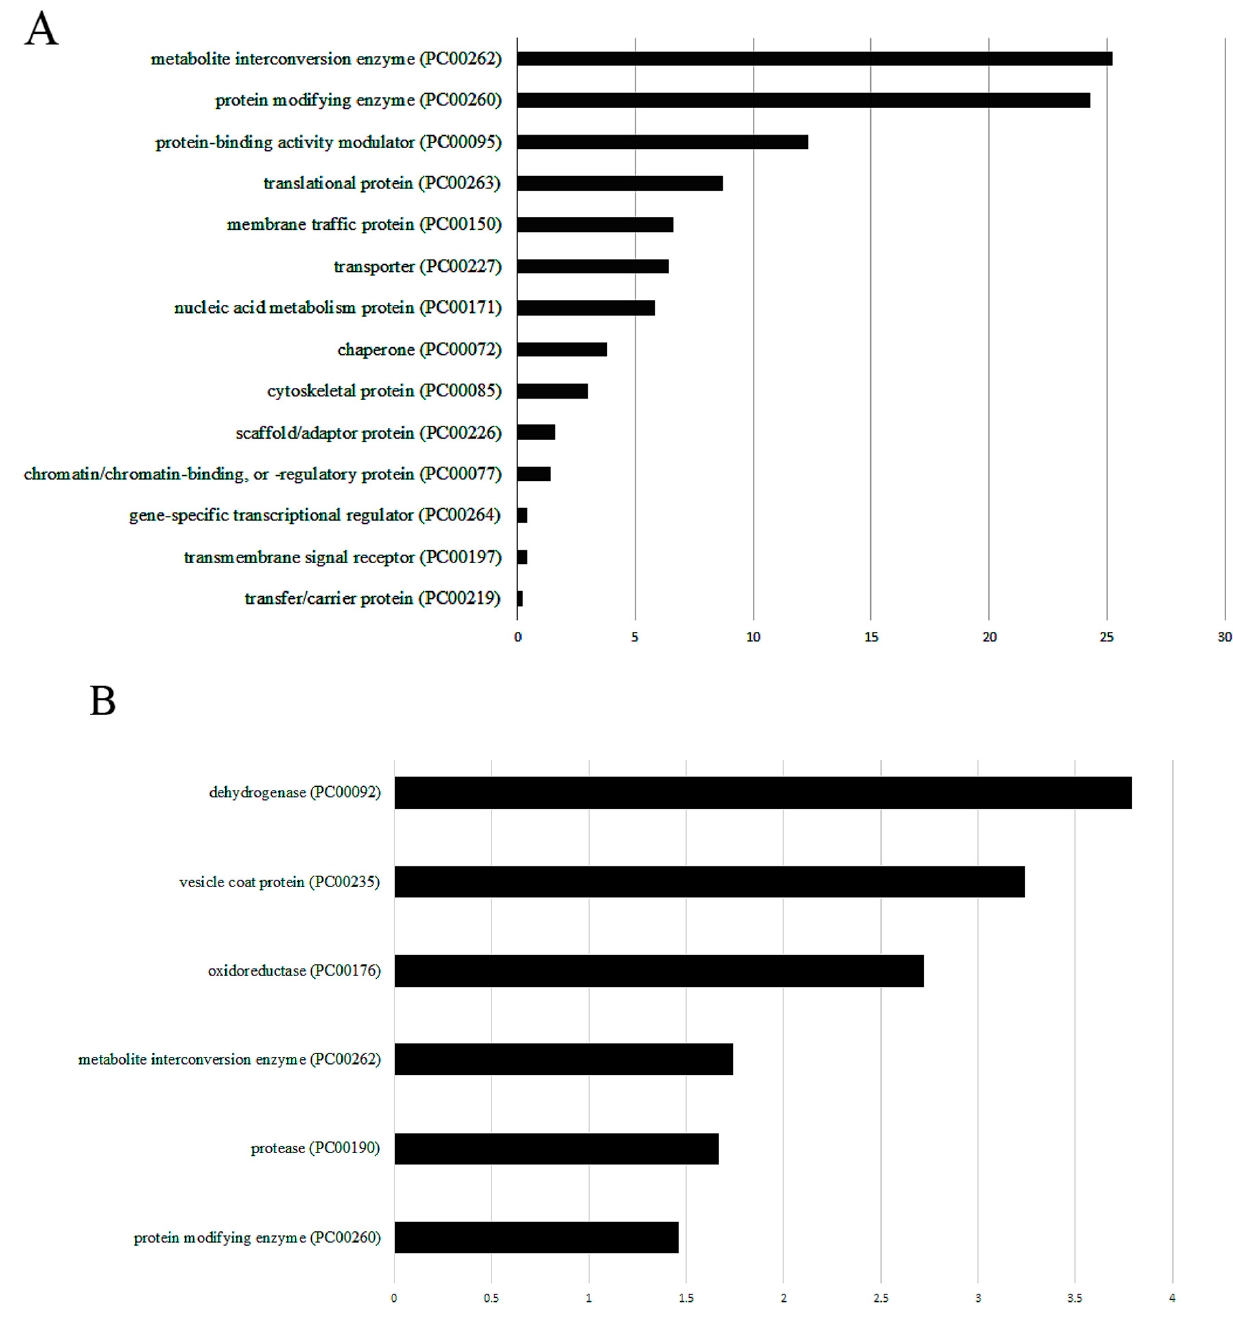
Figure 3. Protein analysis through evolutionary relationships (PANTHER) analysis of OXs in E. histolytica incubated with L. acidophilus. Note: ( A ) PANTHER sequence classification of the OXs identified in E. histolytica trophozoites co-incubated with L. acidophilus . ( B ) PANTHER statistical overrepresentation test of the OXs identified in E. histolytica trophozoites incubated with L. acidophilus . Of the OXs in E. histolytica trophozoites incubated with L. acidophilus (Table S2), oxi- doreductase (PC00176) and dehydrogenase (PC00092), such as glyceraldehyde-3-phosphate dehydrogenase (EHI_008200), NAD(FAD)-dependent dehydrogenase (EHI_099700), and pyruvate: ferredoxin oxidoreductase (EHI_051060), are significantly enriched according to the PANTHER statistical overrepresentation test (Figure 3B). Pyruvate: ferredoxin oxi- doreductase (EHI_051060) is a Fe–S enzyme that catalyzes the oxidative decarboxylation of pyruvate [53]. This protein has also been identified as an OX in trophozoites exposed